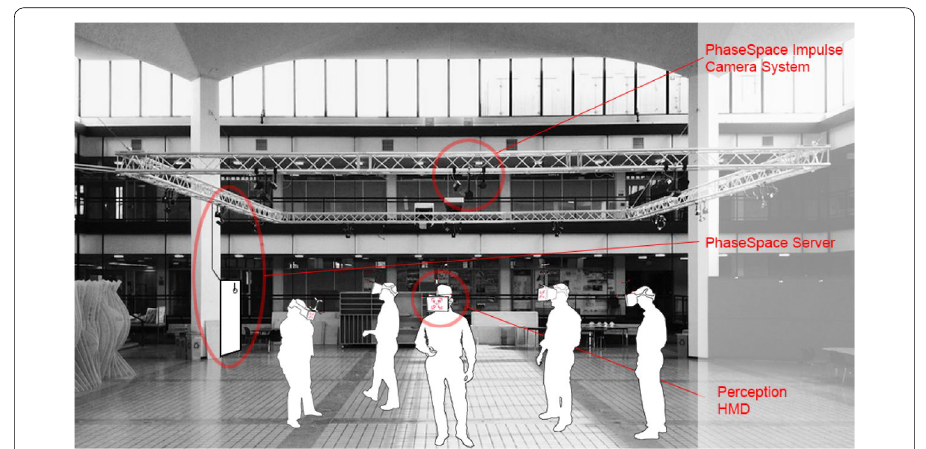
Fig. 2 Virtual reality design lab system